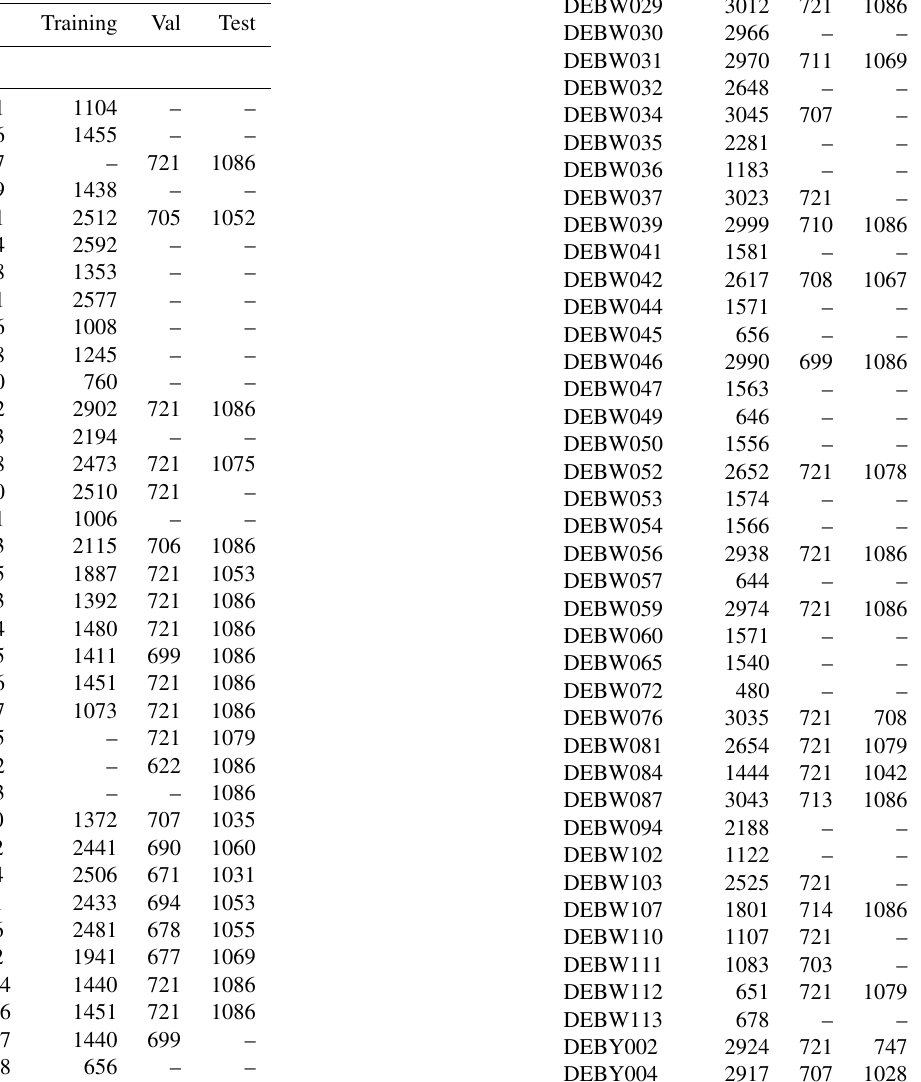
Table A1. Number of samples (input and output pairs) per station separated by training, validation (val), and test dataset. “–” denotes no samples in a